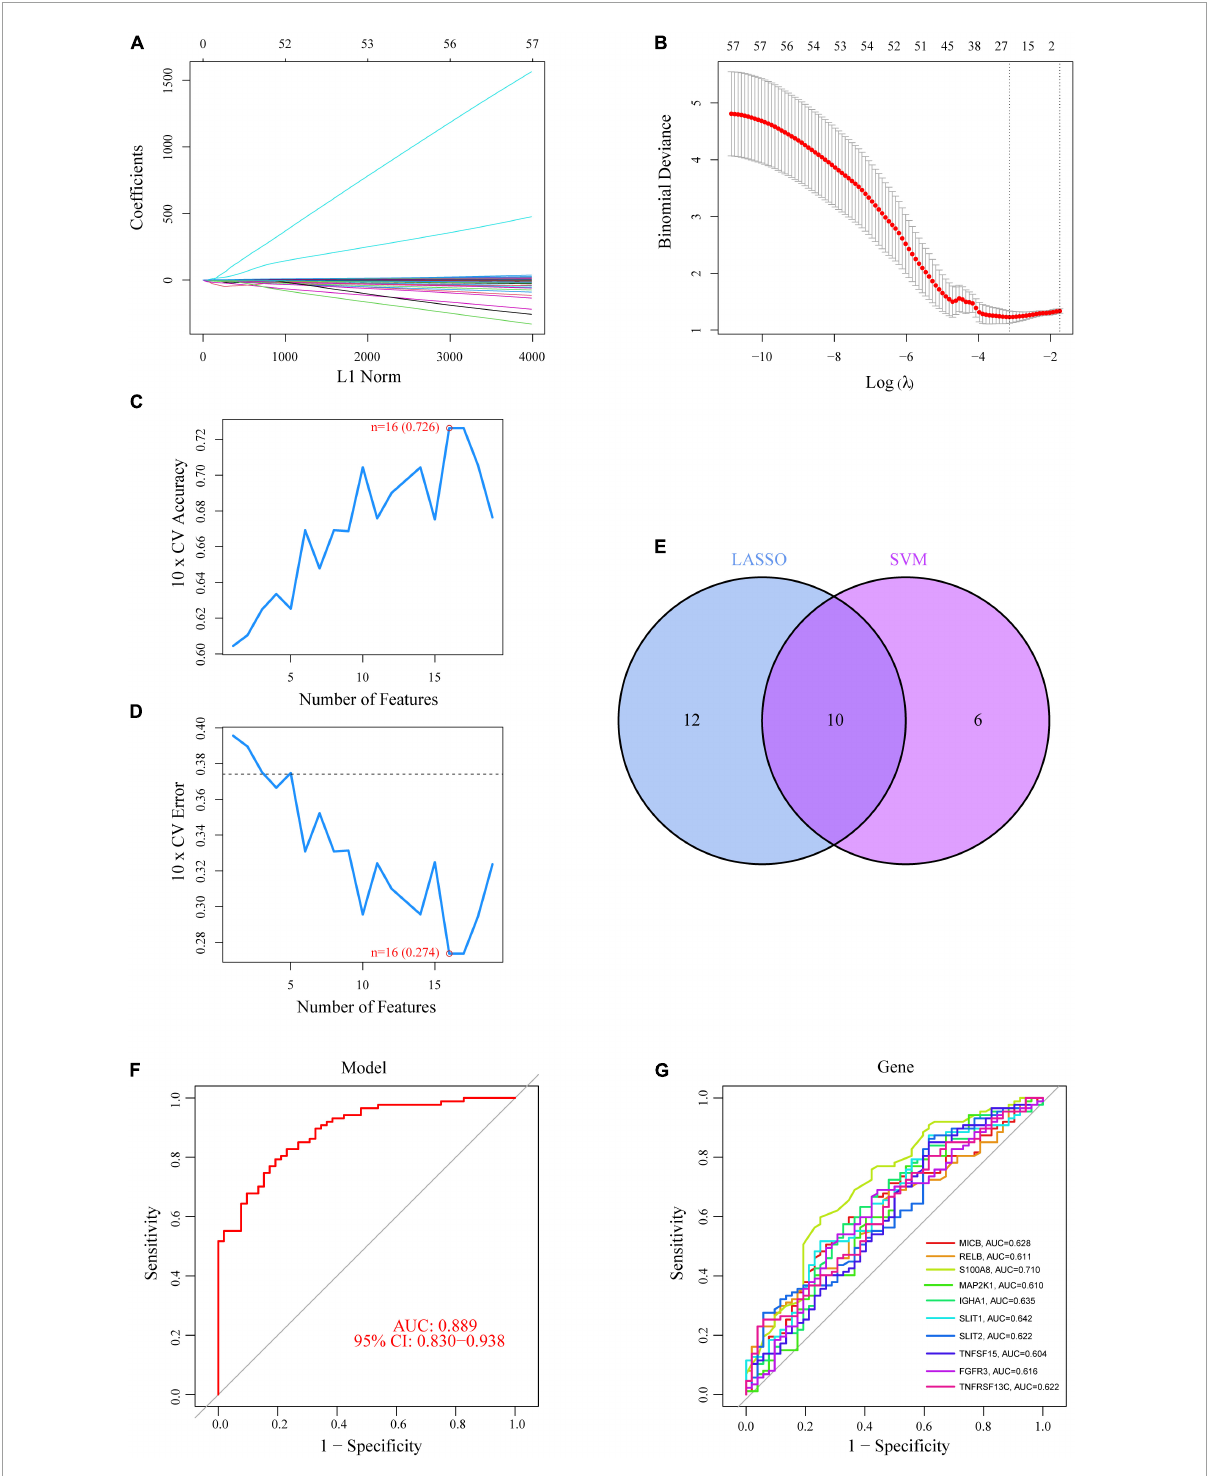
FIGURE3 Ten DE-IRGs were shown to be CAD diagnostic genes. (A,B) Using the LASSO logistic regression algorithm, with penalty parameter tuning conducted by 10-fold cross-validation, 22 CAD-related features were selected. (C,D) The SVM-RFE algorithm was used to filter the 10 DE-IRGs to identify the optimal combination of feature genes. Finally, 16 genes (maximal accuracy = 0.726, minimal RMSE = 0.274) were identified as the OFGs. (E) The 10 marker genes obtained from the LASSO and SVM-RFE models. (F) The AUC for disease samples was determined using a logistic regression model. (G) ROC curves for the 10 marker